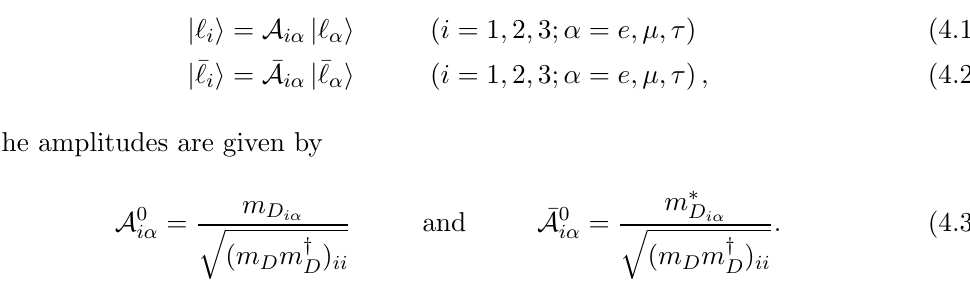
lowering the value of (cid:14) a wide range of RH neutrino mass